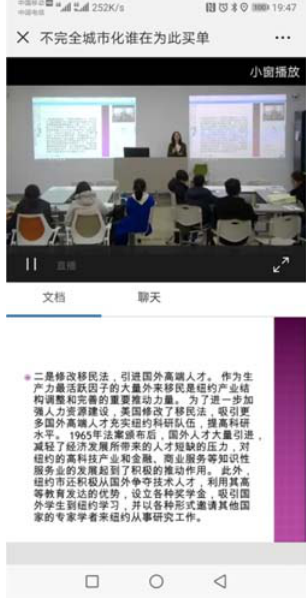
Figure 2. A screenshot of attending a lecture and interact